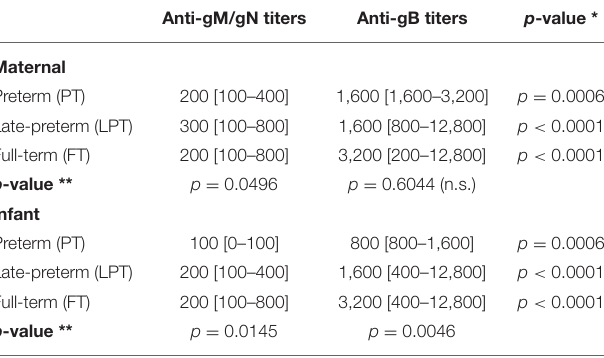
TABLE 2 | Antibody titers among preterm, late-preterm and full term mothers and infants. Anti-gM/gN titers Anti-gB